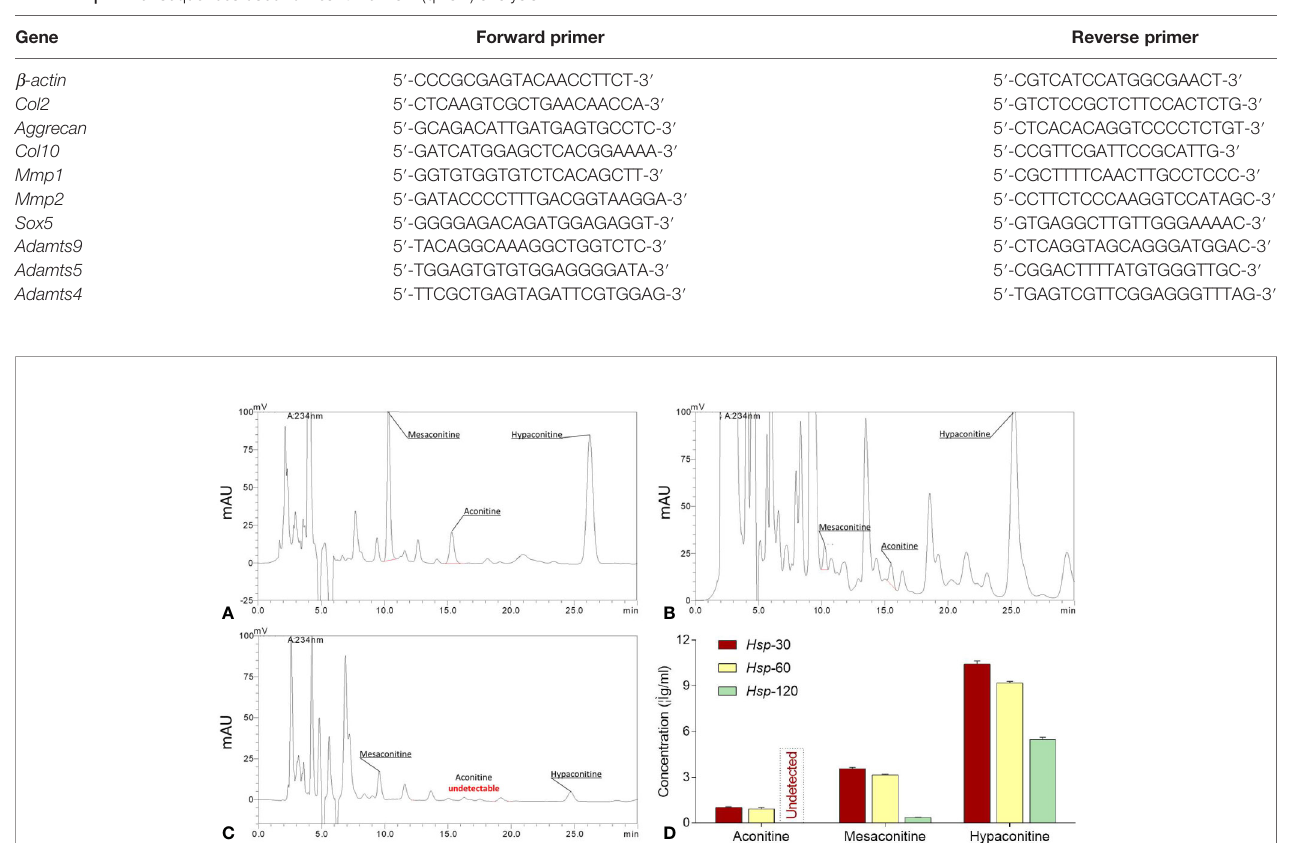
FIGURE 1 | HPLC chromatograms of Hsp -30 (A) , Hsp -60 (B) , and Hsp -120 (C) , and concentrations of aconitine, mesaconitine, and hypaconitine in Hsp -30, Hsp -60, and Hsp -120 (D) .